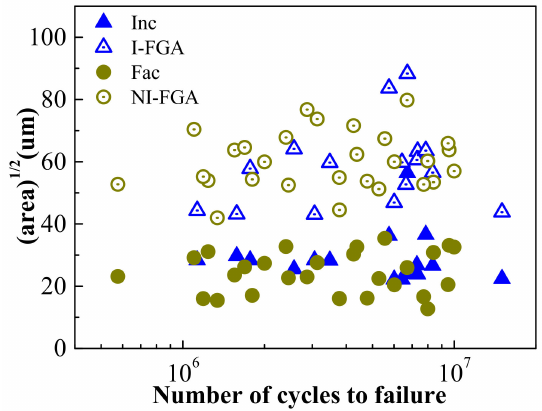
Figure 6. Inclusion, microfacet and FGA size versus applied fatigue life for interior IICI and NIICI mode. Inc and I-FGA: inclusion and FGA in IICI fracture surface; Fac and NI-FGA: microfacet and FGA in NIICI fracture